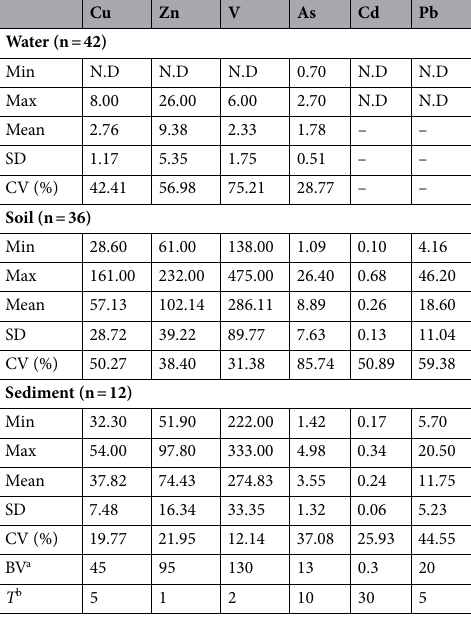
Table 1. Occurrence of trace elements in water, soil, and sediment in the study area. BV Background value of soils in the study area, T Biological toxicity coefficient of element. a Data are from Tuo et al. 37 . b Data are from Hakanson 18 and Xu, et al. 38